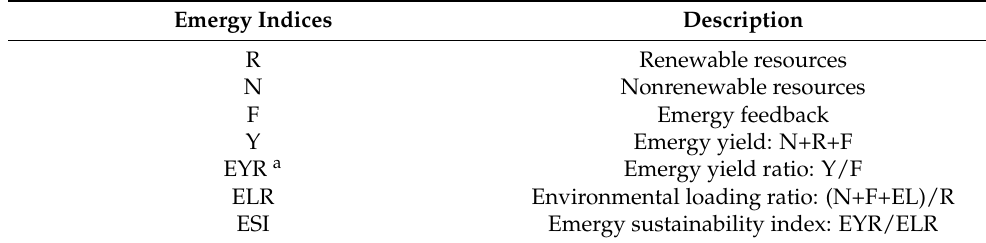
Table 3. Emergy indices and description.